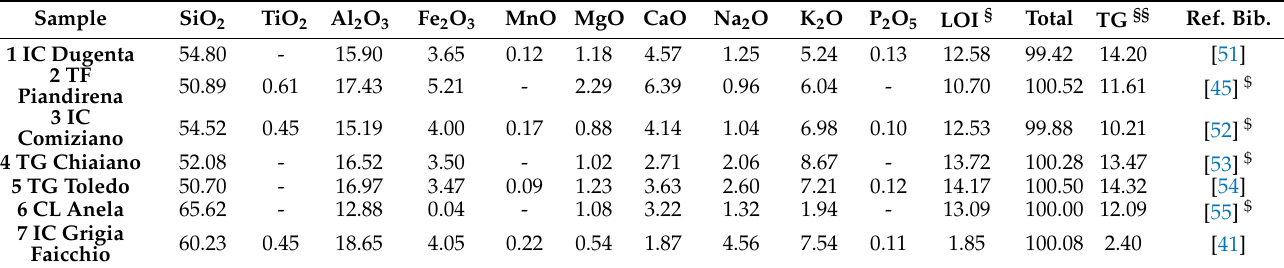
Table 2. Chemical composition of studied pyroclastic rocks.